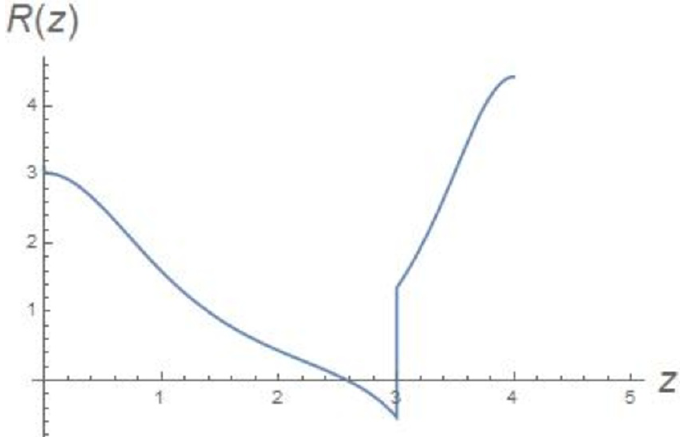
Figure 4. The Ricci scalar associated to the quiver in (cid:12)gure 1.